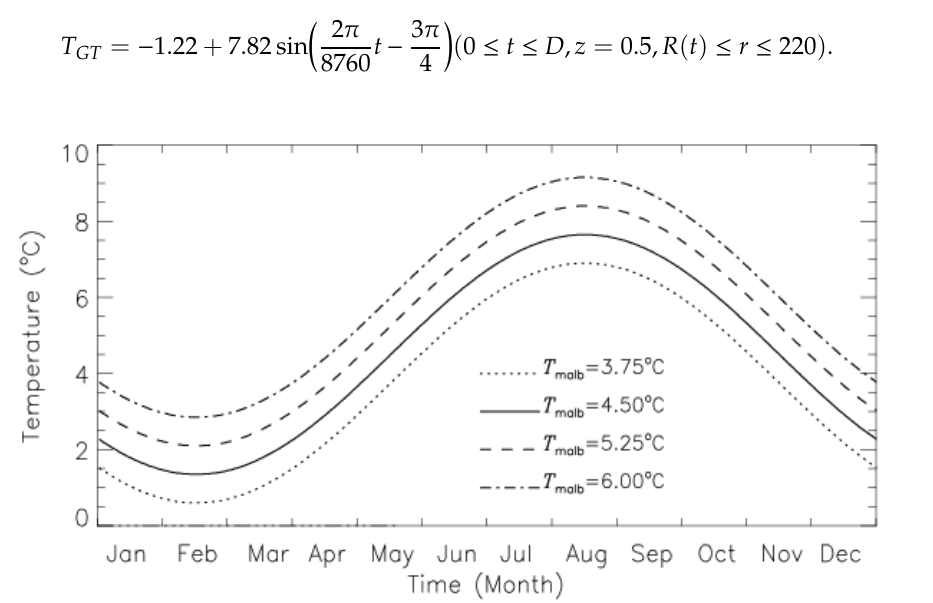
Figure 3. The sinusoidal functions with four mean annual lake bottom temperatures ( T malb ). These are the upper boundary conditions of the lake bottom.